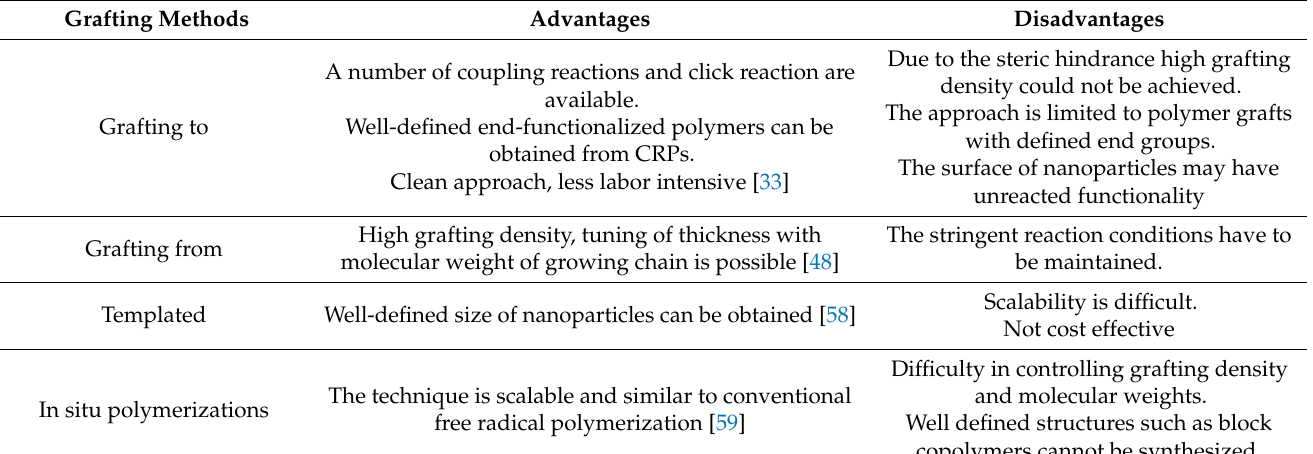
Table 1. Comparison of advantages and disadvantages of polymer grafting